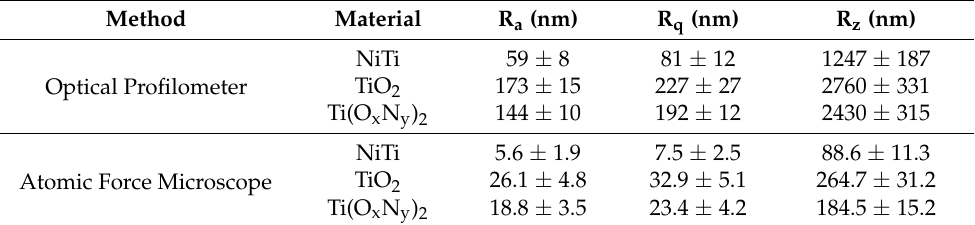
Table 1. Surface roughness of the surface layer produced on NiTi alloy compared with material in the initial